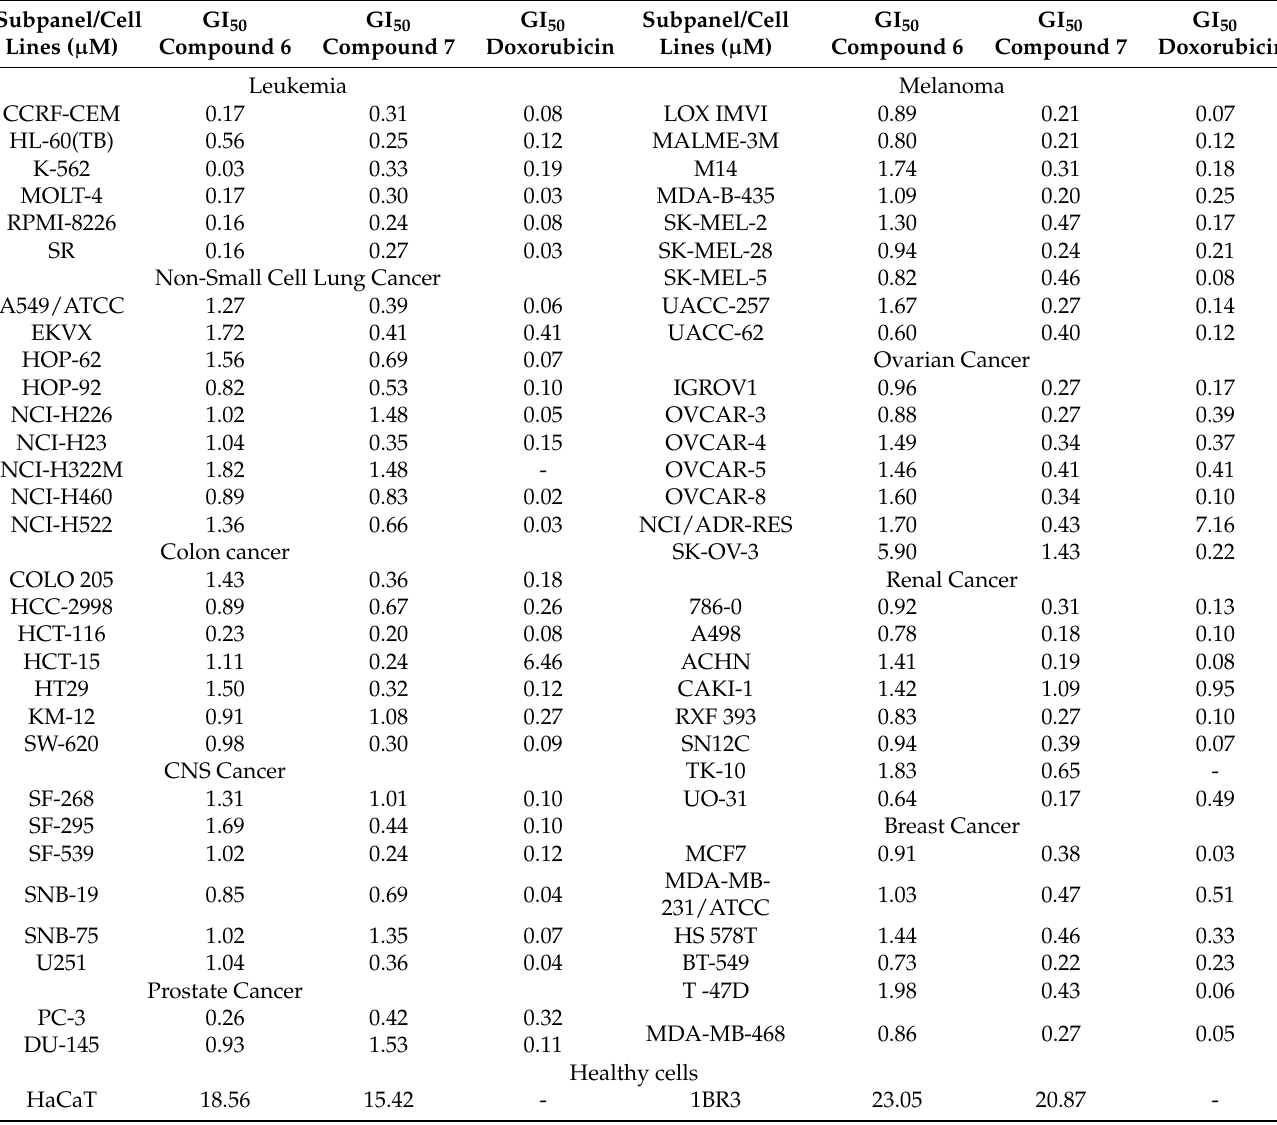
Table 2. In vitro anticancer activity of compounds 6 and 7 against 60 human cancer cell lines, in second stage five dose regimen assessment (0.01–100 µ M) and 2 healthy cell